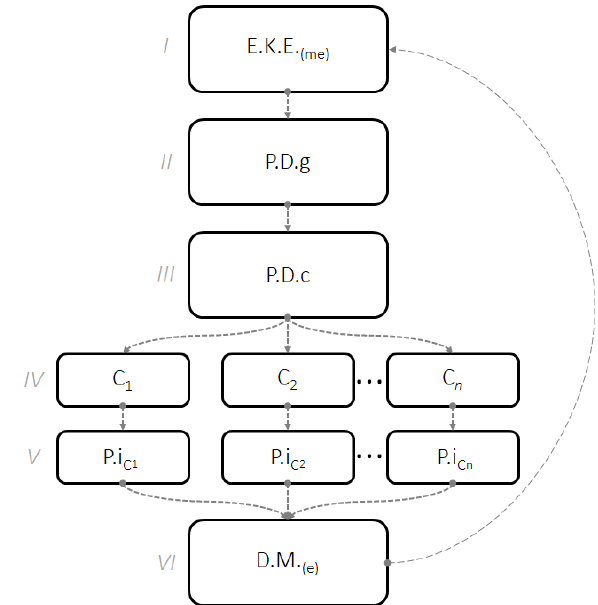
Figure 3. Illustration of the expert knowledge elicitation workflow. E . K . E . ( me ) = expert knowledge elicitation from multiple experts; P . D . g = generation of prior distributions; P . D . c = clustering of prior distributions; C 1 , C 2 . . . C n = cluster 1 to cluster n ; P . i C for each cluster; D . M . ( e ) = decision making with a panel of experts. The long dash arrow from D . M . ( e ) to E . K . E . ( me ) indicates that workflow can be iterated if required. The goal of the